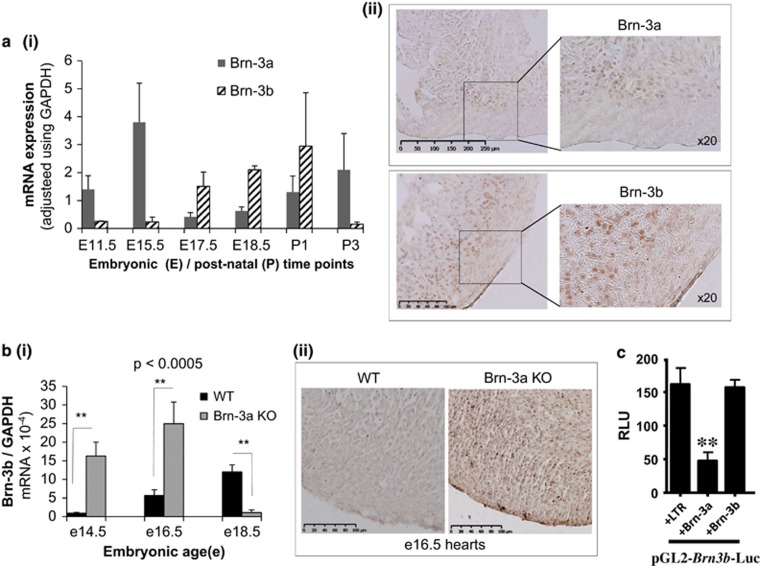
(a) Results of quantitative (q)RT-PCR used to analyse mRNA encoding Brn-3a or Brn-3b in mouse hearts taken from different embryonic (E) or postnatal (P) hearts. Values shown were adjusted for total RNA variability using the GAPDH housekeeping gene and similar changes were seen with other housekeeping genes, B2M and ACTN (not shown). Data represents mean and S.D. from values from >4 individual hearts. (ii) Representative DAB immunostaining images showing protein localisation of Brn-3a (top panels) or Brn-3b (bottom panels) in sections of foetal (e18.5) WT mouse hearts. (b) (i) qRT-PCR data showing Brn-3b mRNA levels in hearts taken from Brn-3a KO-mutant embryos and age-matched WT controls at embryonic day, e14.5, e16.5 or e18.5. Data represents the mean and S.E.⩾5 independent hearts of each genotype at each time point. **Represents statistical significance, as determined by t-test with P<0.05. (ii) Representative images of e16.5 embryonic heart sections taken from WT or Brn-3a KO embryos following DAB immunostaining for Brn-3b protein. (c) Results of reporter assays to analyse Brn-3b promoter activity in NRVM cultures when co-transfected with Brn-3a and compared with Brn-3b or the empty vector control (LTR). The firefly luciferase reporter gene activity is shown as RLU and variation in transfection efficiency was adjusted using internal control, TK renilla. Values represent the mean and S.E. from three independent experiments and **Indicates statistically significant differences <0.05. RLU, relative luciferase unit; WT, wild-type